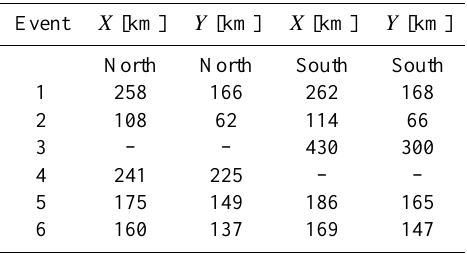
Table 4. TS96 ionospheric footprint location in magnetic latitude and local time (UT) coordinates. The subindices refer to the mapped field line locations ending in the northern (N) or southern (S) pole.